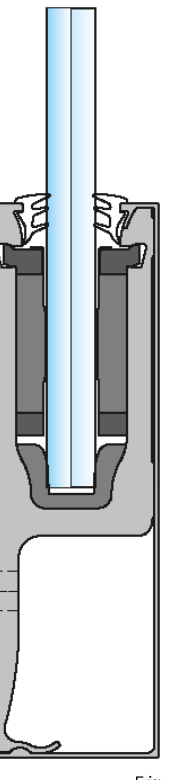
Fig. 2 Pauli + Sohn Ltd. system profile set cp-1402 for side